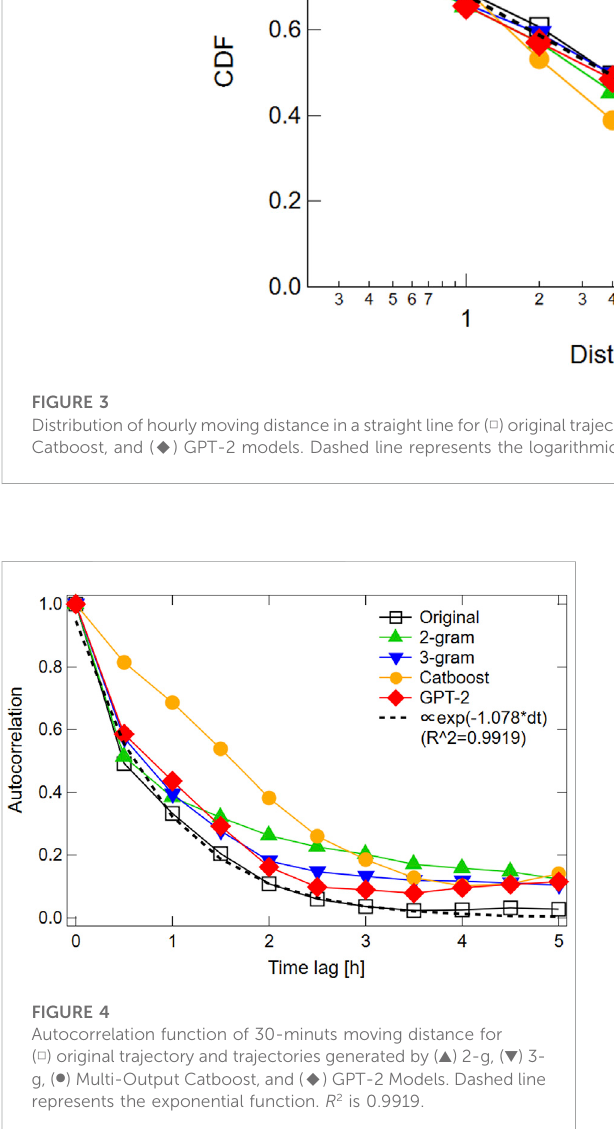
FIGURE 4 Autocorrelation function of 30-minuts moving distance for ( □ ) original trajectory and trajectories generated by ( ▲ ) 2-g, ( ▼ ) 3- (cid:129) g, ( ) Multi-Output Catboost, and ( A ) GPT-2 Models. Dashed line represents the exponential function. R 2 is